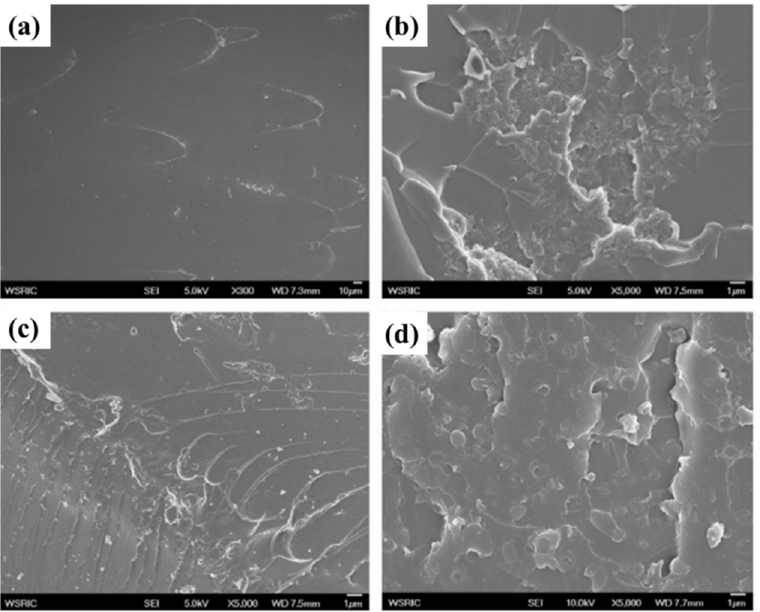
Figure 7. The SEM images of fractured surfaces under impact test at 77 K of ( a ) neat epoxy, ( b ) PBT modified epoxy, ( c ) PC modified epoxy and ( d ) PEI modified epoxy. Reused with permission from Ref. [49]. Copyright 2013 Elsevier.